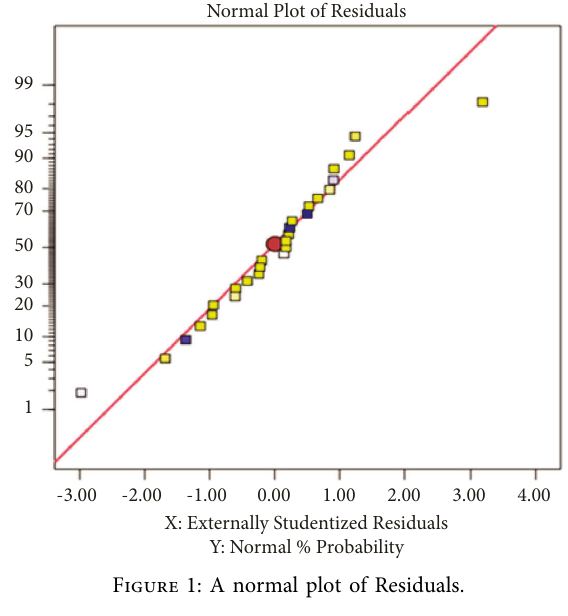
Figure 1: A normal plot of Residuals.